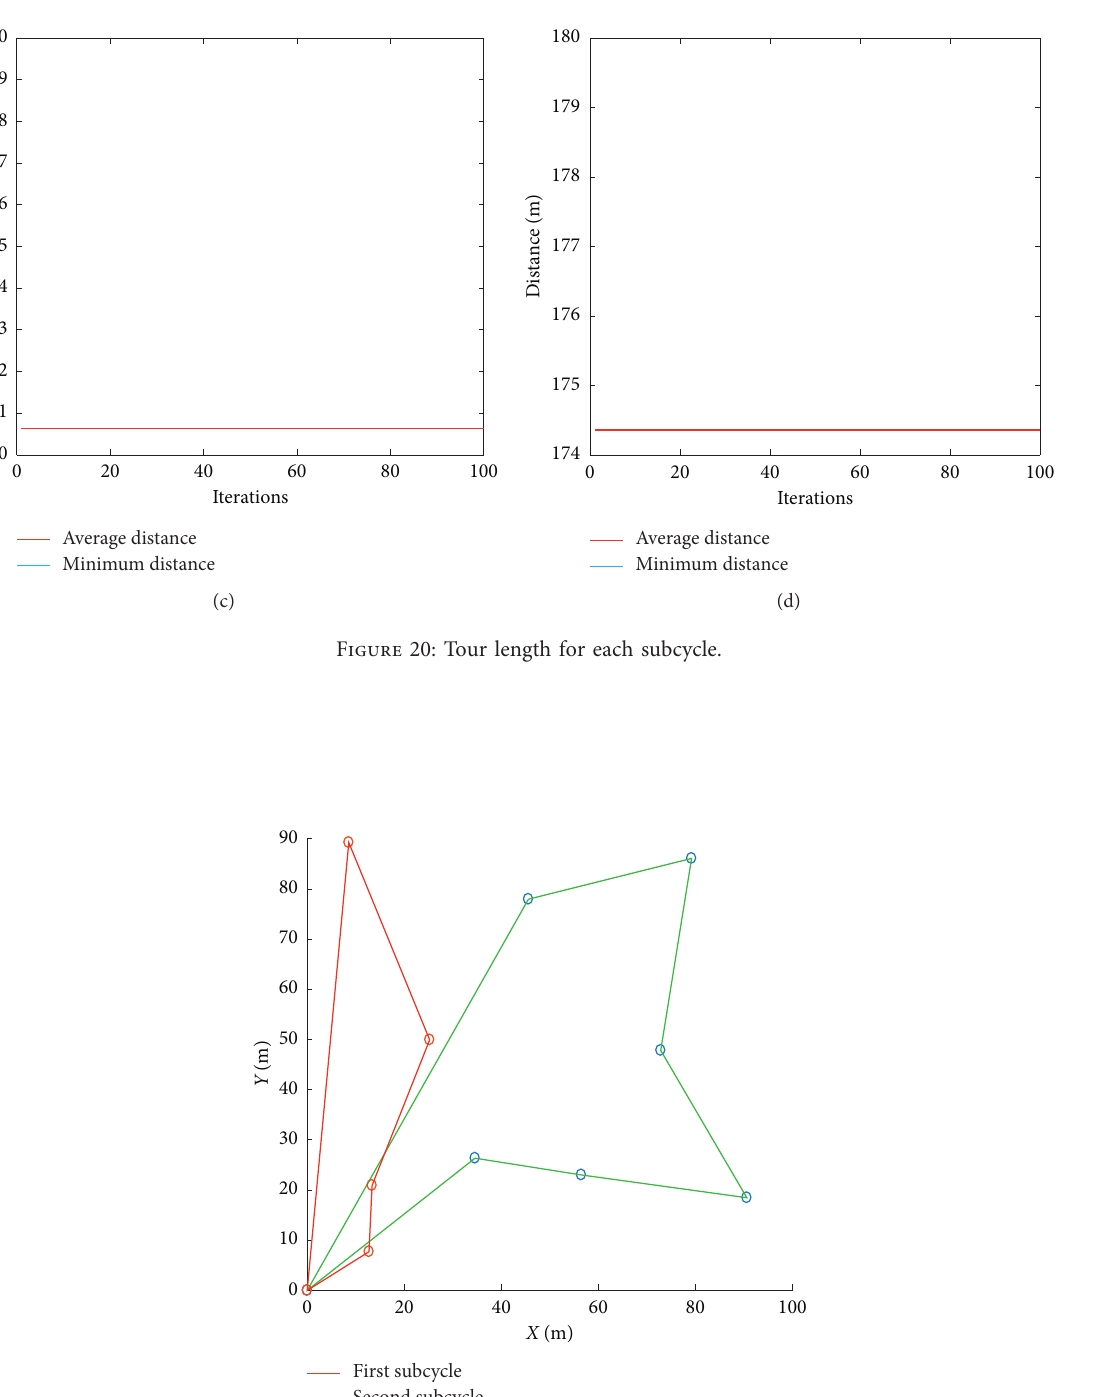
Figure 21: The first two subtours with a limitation of a maximum continuation length of 300 meters.